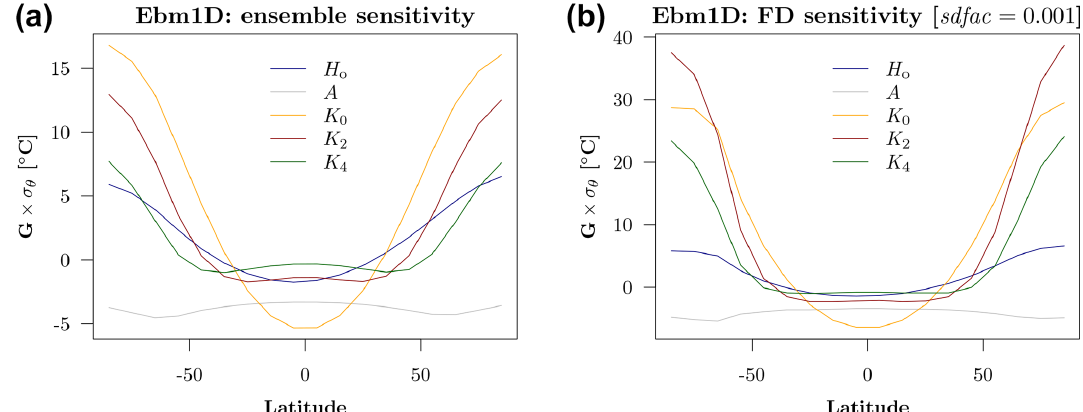
Figure 1. Ebm1D experiment. Background sensitivity of winter surface air temperature to the control variables estimated as (a) ensemble sensitivity (for the ETKF) and (b) finite-difference sensitivity (for the FDS-IKS and the FDS-MKS) with SDfac = 0 . 001. Sensitivities are scaled by the standard deviation of the control variables, and each line refers to a column in G . Each plot uses its own scale to ease visualization. Table 2. Ebm1D PD1 tests. Parameter estimation and cost function values ∗ .